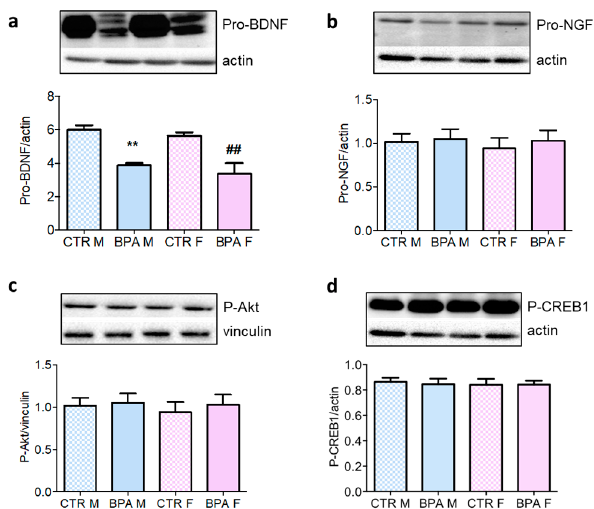
Figure 7. Pro-BDNF, Pro-NGF content, Akt and CREB1 phosphorylation in the brain of rat fetuses in utero exposed to 2.5 µg/kg/day of BPA. Representative Western blot and densitometric analysis of pro-BDNF ( a ) and pro-NGF levels ( b ), CREB-1 ( c ) and Akt phosphorylation ( d ) performed on brain lysates from prenatally exposed to BPA and CTR animals. n = 6 for each experimental group. Vinculin or actin served as housekeeping proteins. Statistical analysis was carried out by using two-way ANOVA followed by Bonferroni post-hoc test. ** = p < 0.01 vs. CTR M; ## = p < 0.01 vs. CTR F.